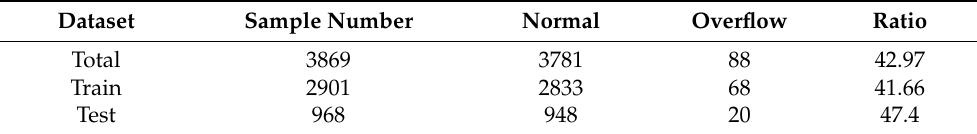
Table 2. A simple view of data used in training and